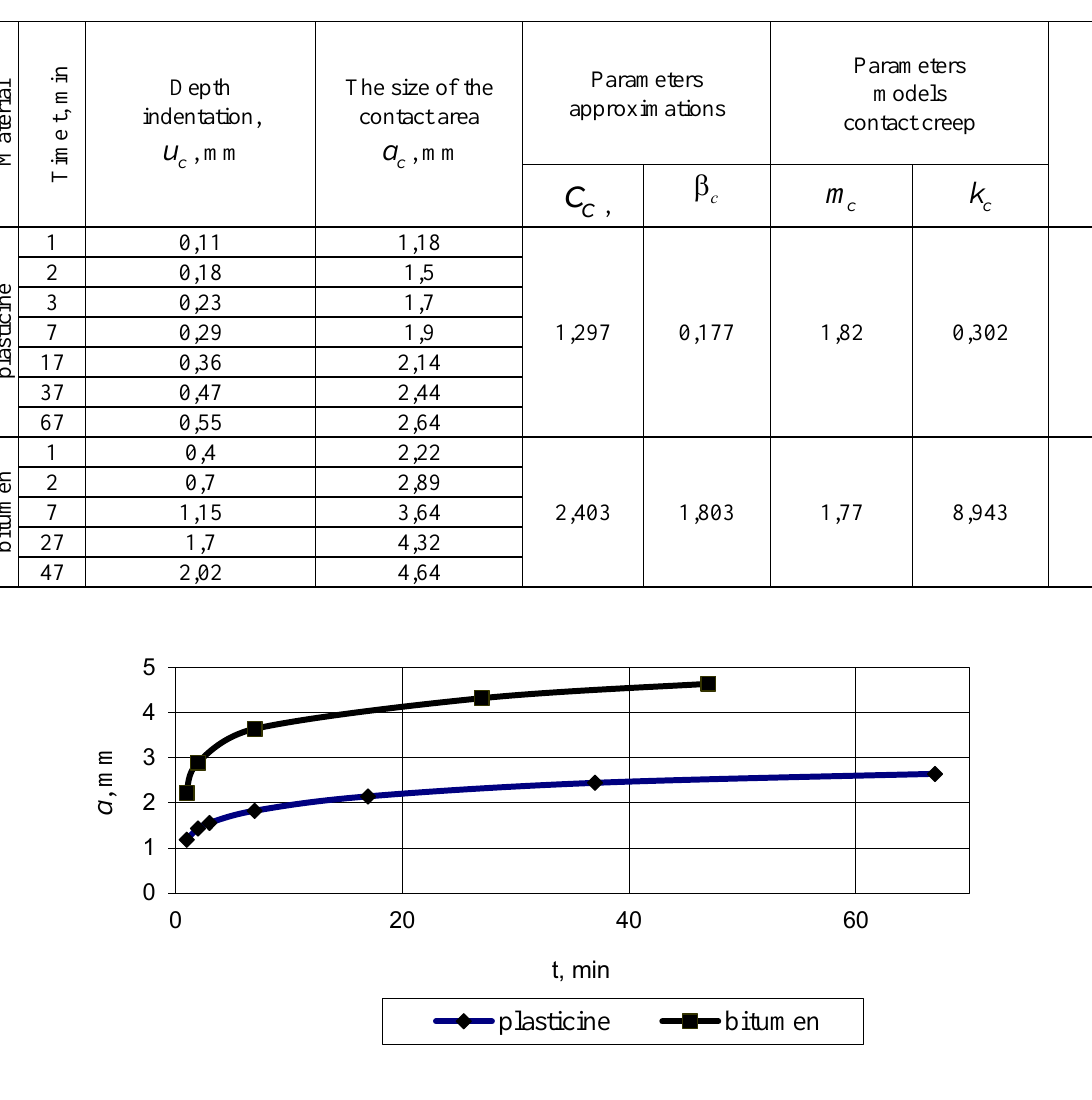
Fig. 2. The results of studies on contact